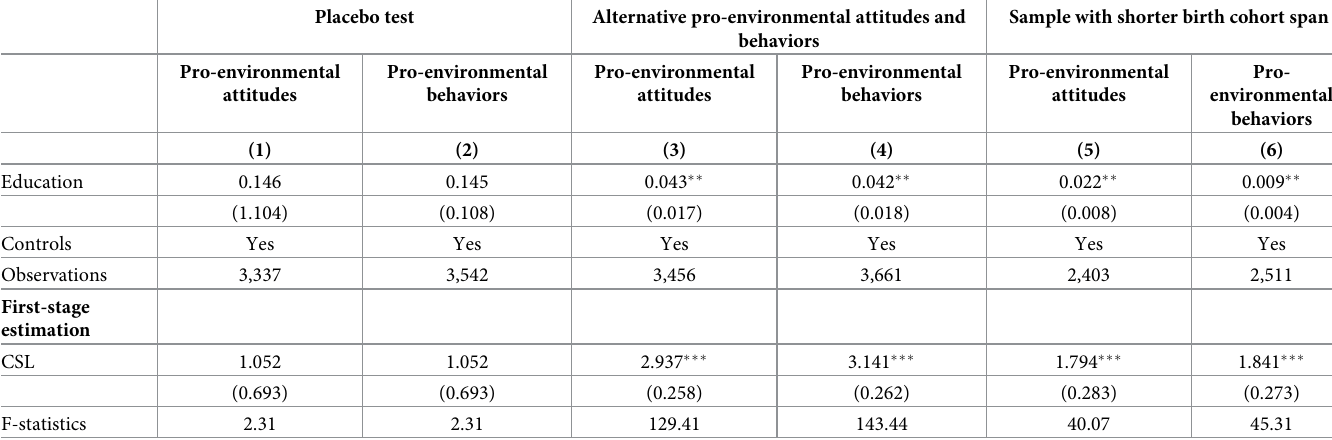
Table 6. Robustness